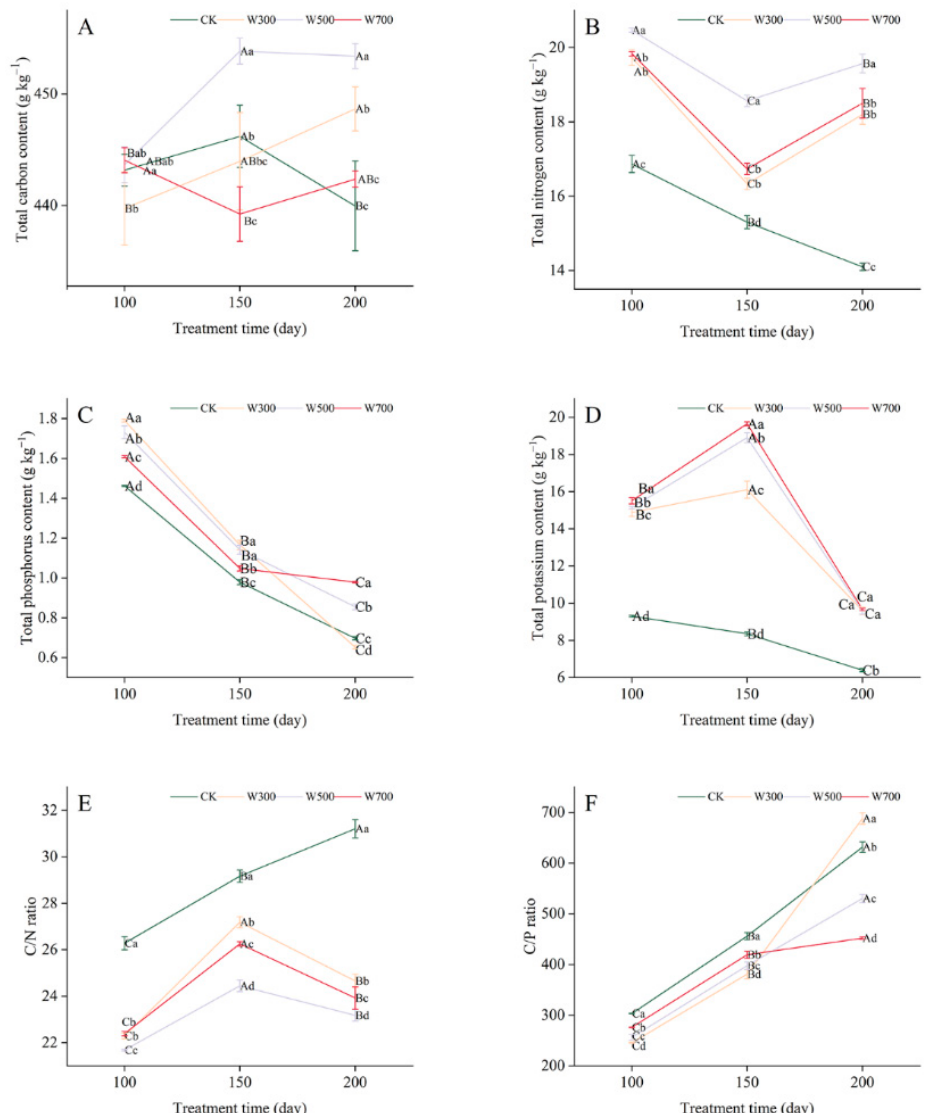
Figure 5. Effects of biochar pyrolyzed at different temperatures on the total contents of carbon ( A ), nitrogen ( B ), phosphorus ( C ), and potassium ( D ) in the leaves of C. paliurus , as well as the ratio of C/N ( E ), and C/P ( F ) at 100, 150 and 200 days after treatment. CK: without biochar; W300: with biochar pyrolyzed at 300 °C; W500: with biochar pyrolyzed at 500 °C; W700: with biochar pyrolyzed at 700 °C. Different uppercase letters represent significant differences among the different sampling times in the same treatment, while different lowercase letters indicate significant differences among different treatments at the same sampling time according to Duncan’s test ( p < 0.05), respectively. There were significant differences in the ratios of C/N and C/P among the treatments (Figure 5E,F). During the experimental period, the C/N in CK was higher than those in the biochar addition treatments, and the lowest C/N was observed in W500 treatment at all sampling times. As presented in Figure 5F, the C/P for all treatments maintained an increased trend with the extension of treatment time. At 200 days after treatment, the greatest C/P in C. paliurus leaves was found in W300, reaching 687.95. Compared with CK, the C/P increased by 8.94% in W300 but had decreased by 16.03% in W500, and 28.42% in W700, respectively, by the end of the experiment (200 days).